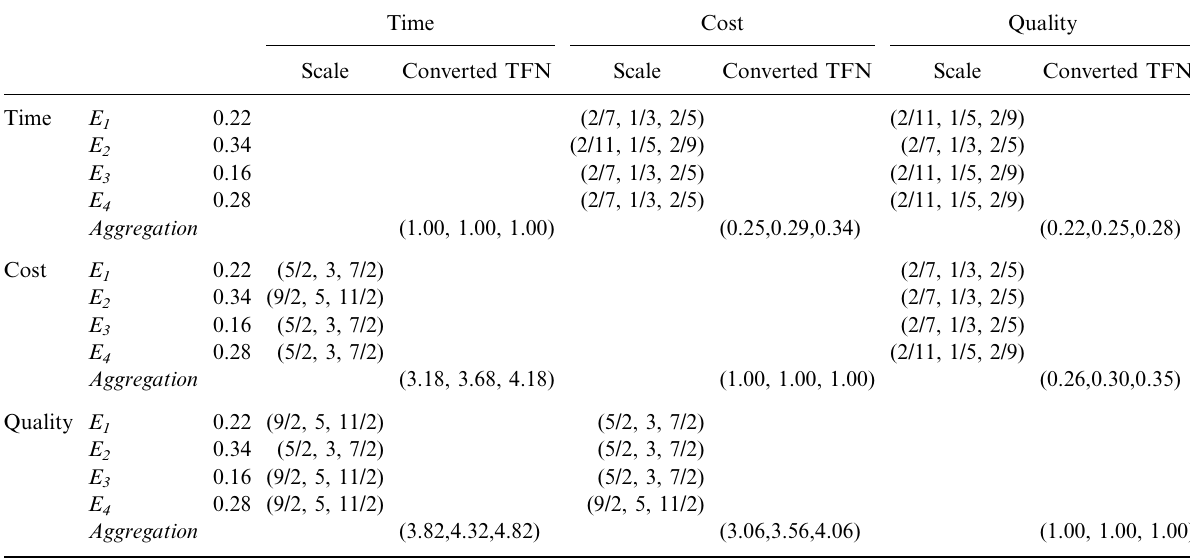
Table 5. Evaluation of sub-criteria with respect to ‘‘Weather’’ (Level 4)